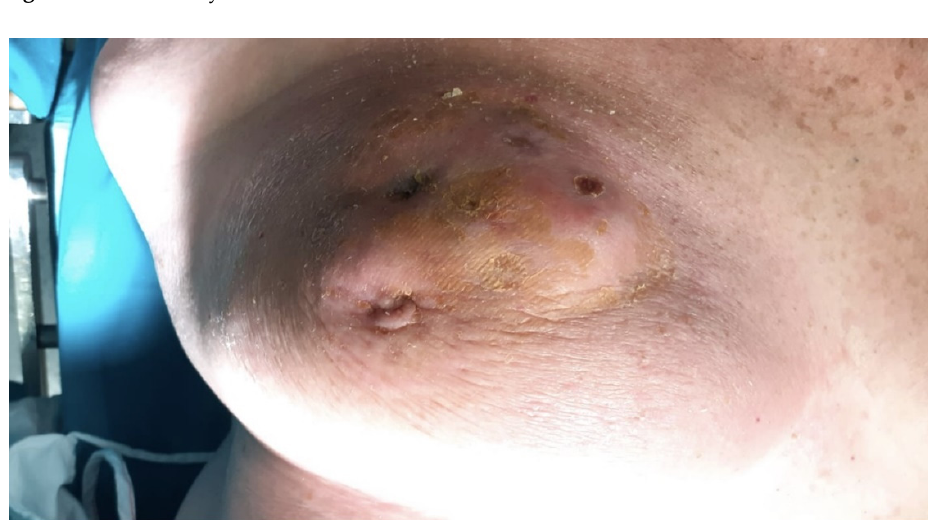
Figure 8. Picture after 30 days of application of the device. Clear local improvement of the skin and reduction of lesion areas.